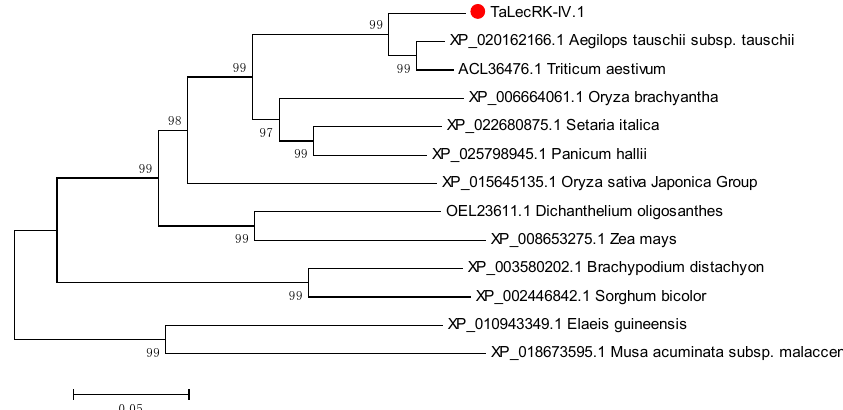
Figure 1. Phylogenetic analysis of the predicted plant proteins in the Genbank and TaLecRK-IV.1 protein deduced from the coding sequence of TaLecRK-IV.1 . Red dot indicates TaLecRK-IV.1 protein. Database accession numbers and the name of the species are shown. The phylogenetic tree